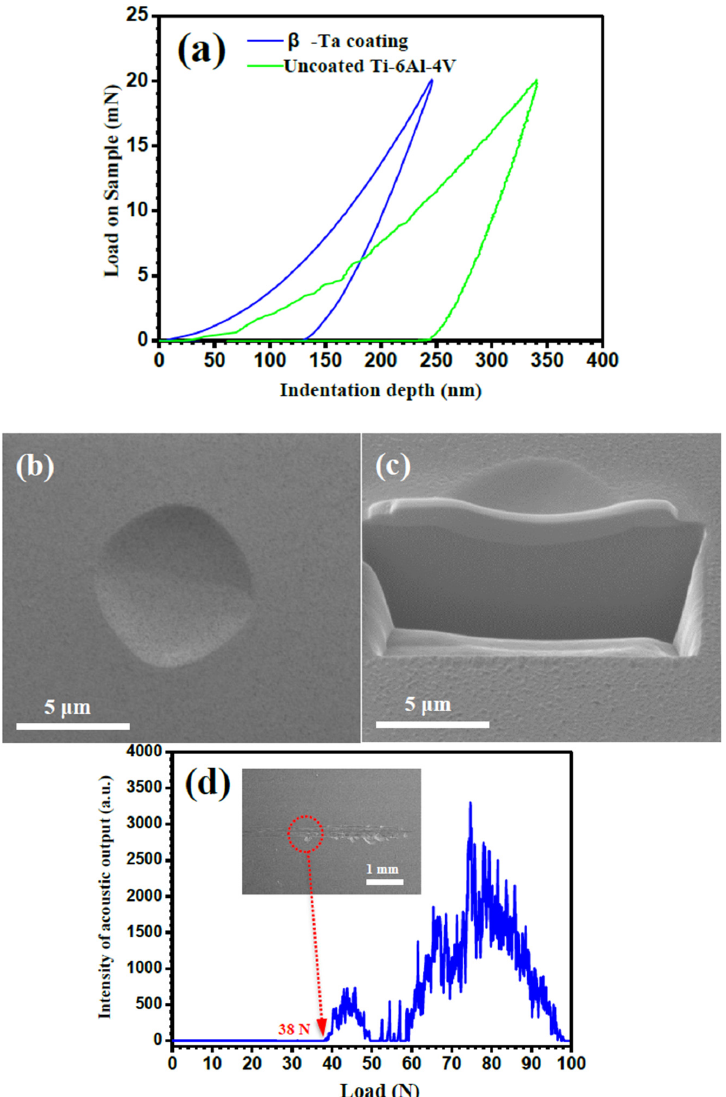
Figure 4. ( a ) Load–displacement curves of the β -Ta coated and uncoated Ti-6Al-4V; ( b ) plan view SEM image and ( c ) FIB cross-sectional image of Vickers indentation in the β -Ta coating under a load of 500 mN; and ( d ) acoustic emission signal versus normal load for the β -Ta coating together with the corresponding SEM micrograph of the scratch track (inset).